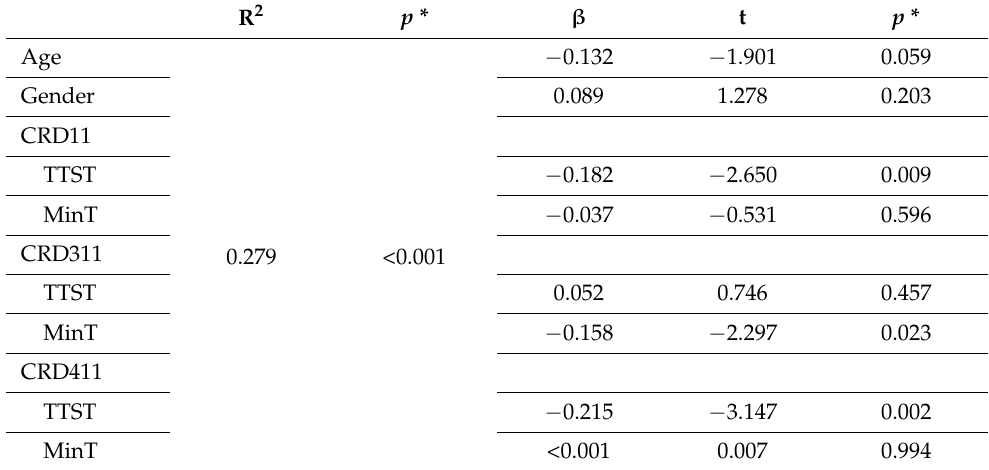
Table 3. Regression analysis of APM score based on the multiple linear regression model including total test-solving time (TTST) and minimum single-task-solving time (MinT) on CRD11, CRD311, and CRD411 tests, age and gender of medical students assessed in the study. R 2 p * β t p * − 0.132 − 1.901 Age 0.089 0.203 0.279 <0.001